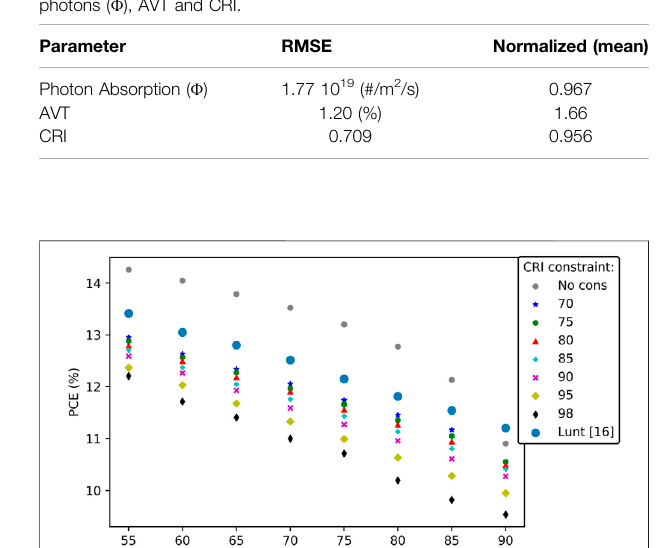
TABLE 1 | Parameters used in the PVtrace ray trace algorithm [24]. Parameter Value